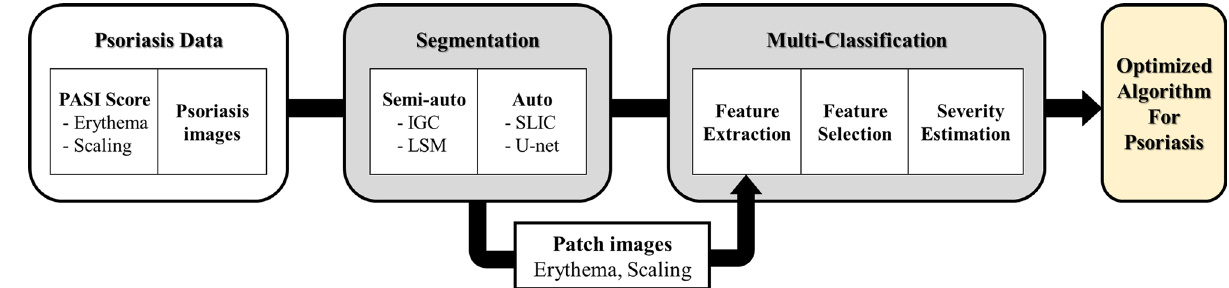
Figure 1. Outline of our proposed psoriasis severity assessment system. It shows the overall structure of the psoriasis severity assessment system proposed in this study. First, we compared the psoriasis segmentation results of the four segmentation methods and selected the segmentation methods with the best performance. We then obtained patch images of erythema and scaling using the best segmentation images and generated a new dataset including patch images. Next, we classified psoriasis severity based on psoriasis features (texture, color, and spectrum) using a new dataset. Through two stages, we present a segmentation method and a classifier optimized for psoriasis